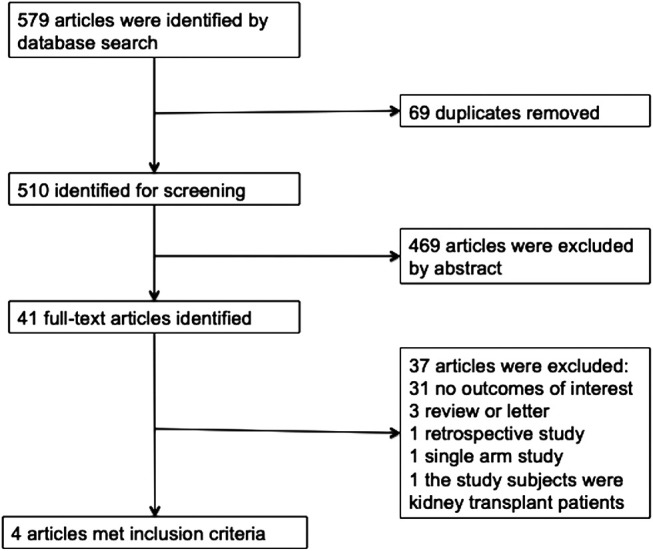
Eligibility of the studies for inclusion in the meta-analysis.